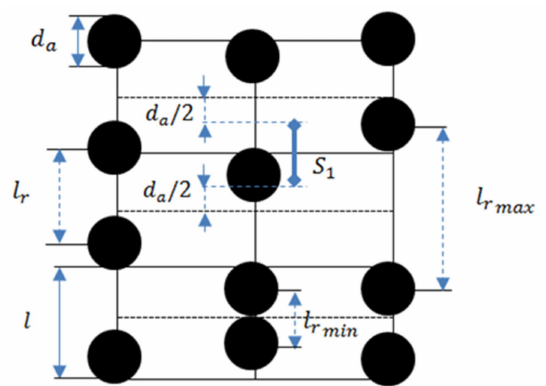
Figure 11. Sketch of the cubic lattice. The centers of each agglomerate can be located at any point within its segment S 1 .